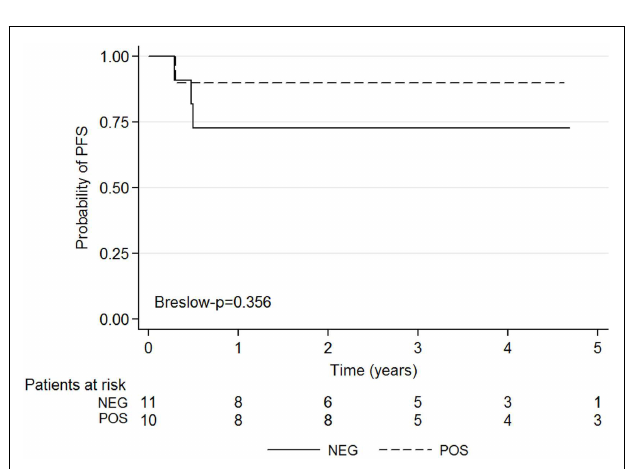
FIGURE 4 | Kaplan–Meier survival graphs show 5-year PFS according to negative and positive post-induction chemotherapy CI results .